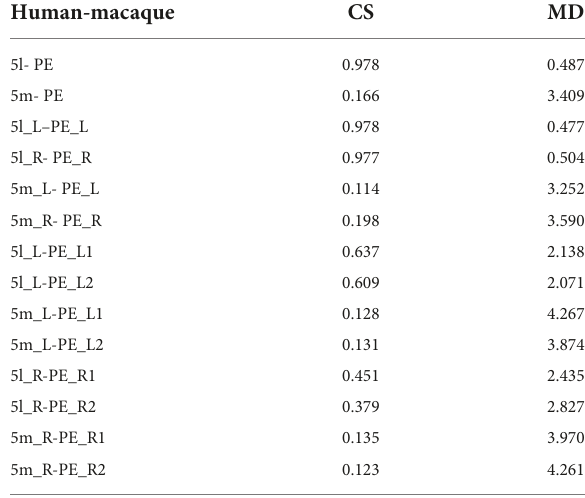
Dice Sen. Spc. IoU